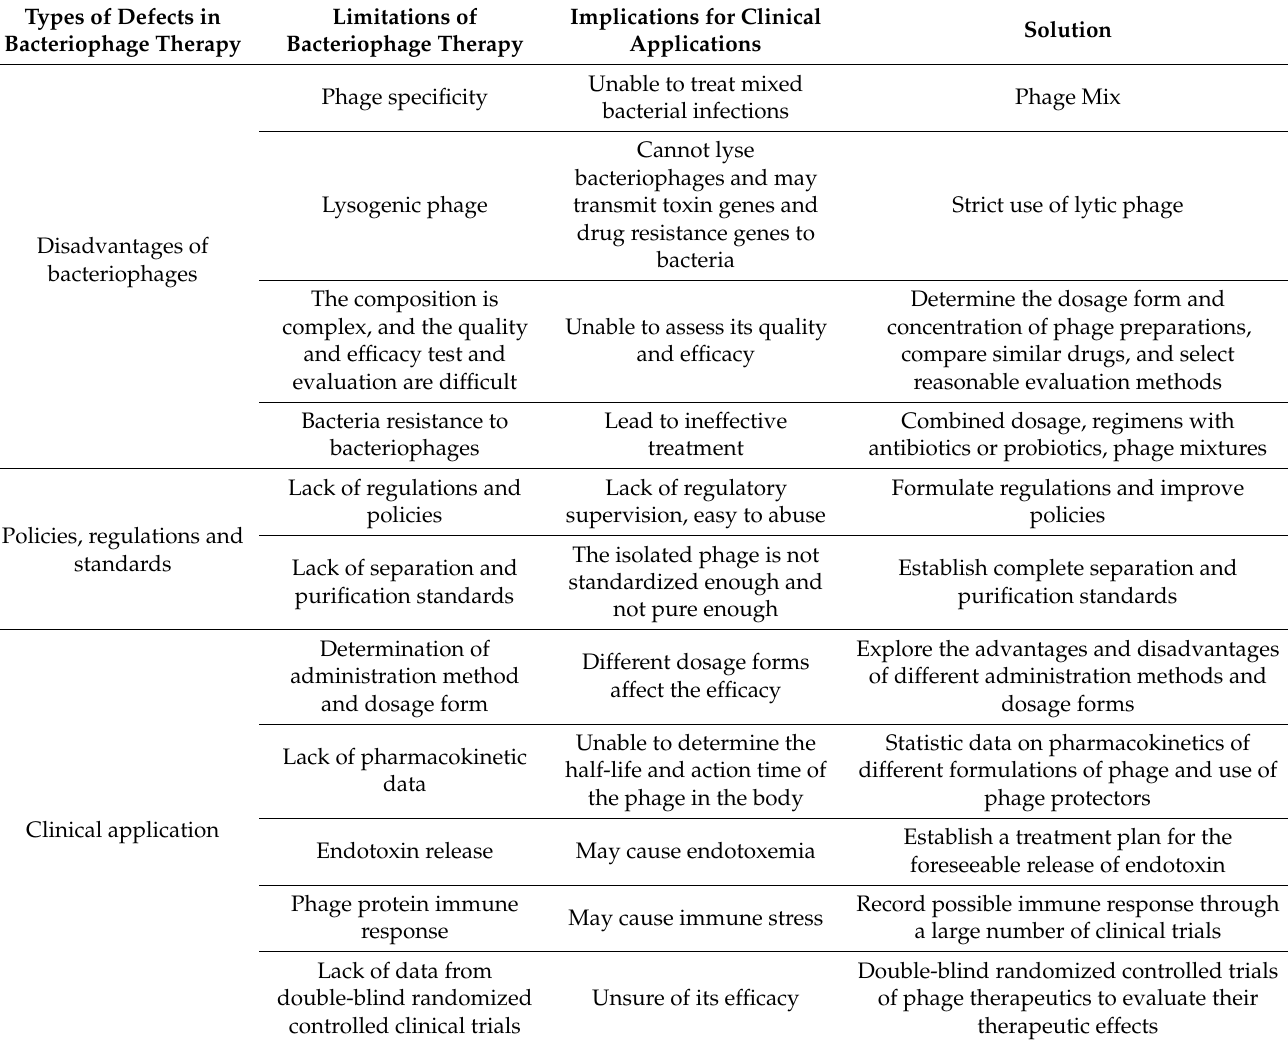
Table 2. Limitations of PT, their impact on clinical applications, and